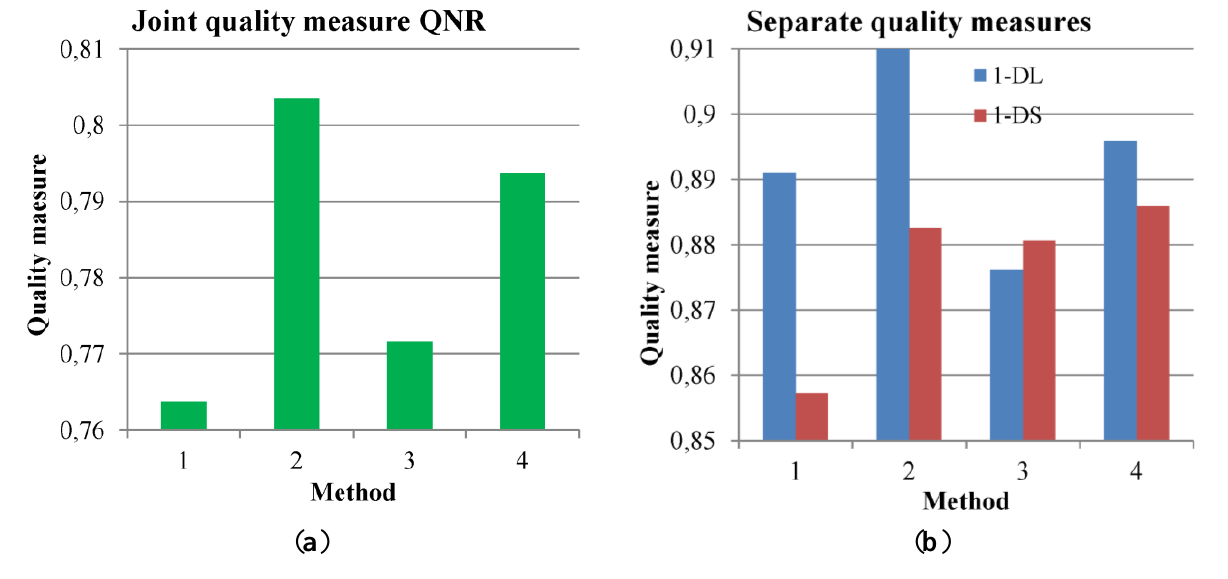
Figure 2. Quality with no Reference (QNR) quality assessment of interpolation methods: